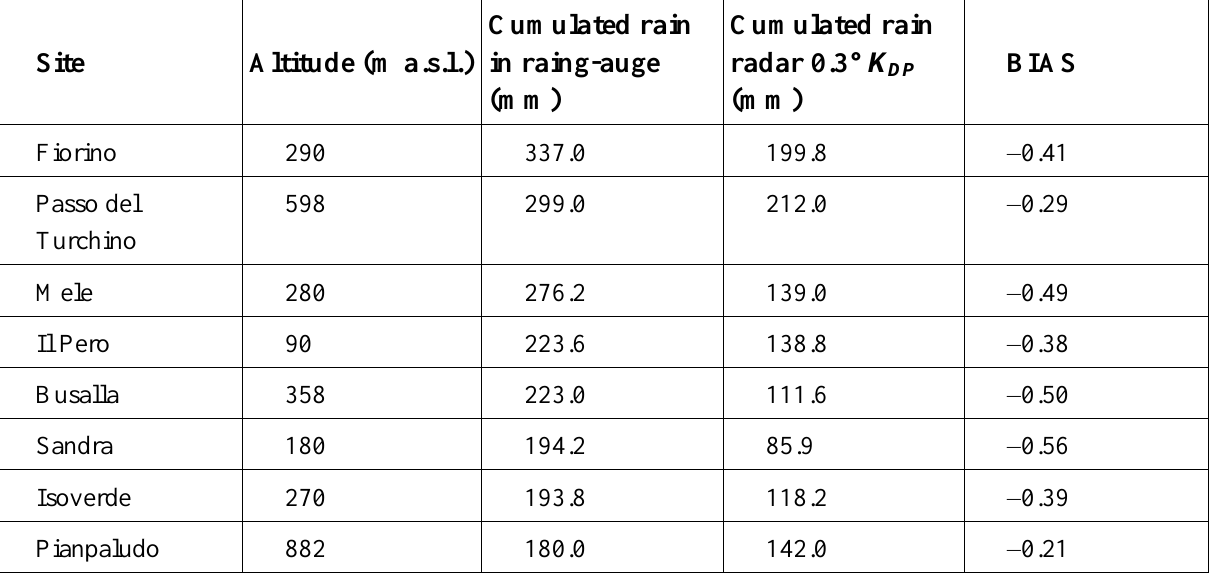
Table 2 . Comparison between radar derived rain and raingauges